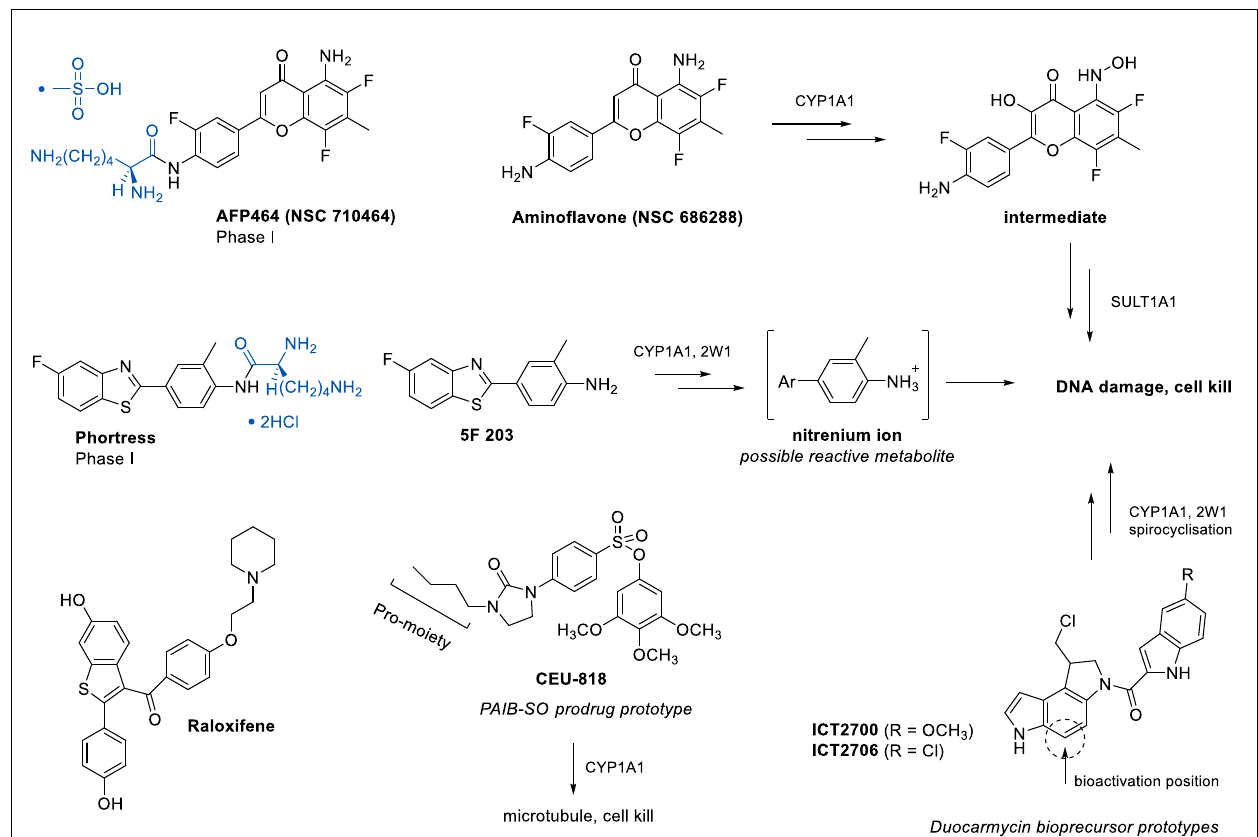
Figure 3. Prodrugs and bioprecursors targeting CYP1A1 or CYP1A1/2W1 for tumour-selective bioactivation.